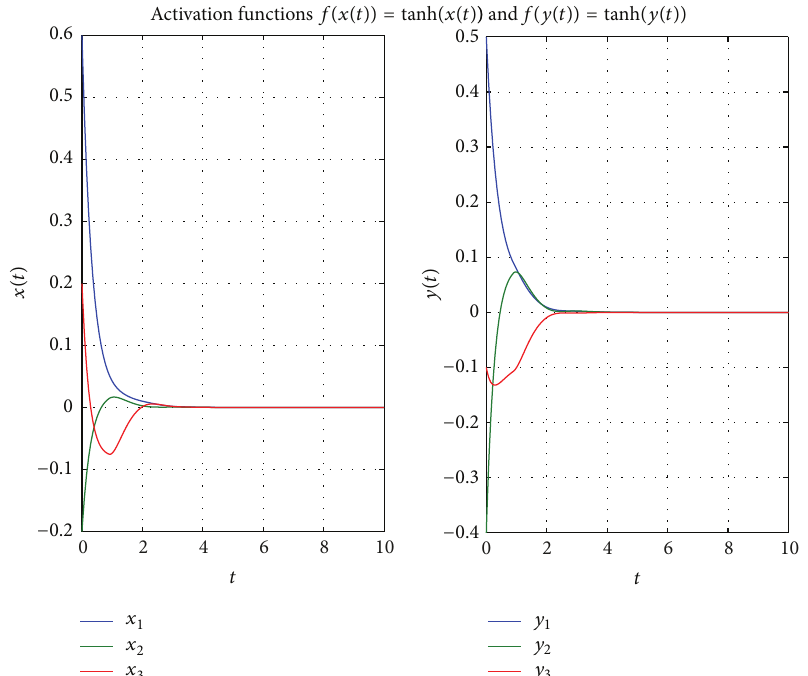
Figure 1: Trajectories of 𝑥(𝑡) and 𝑦(𝑡) of system (8) for the initial states 𝑥(0) = [0.6 −0.2 0.2] and 𝑦(0) = [0.5 −0.4 −0.1] .